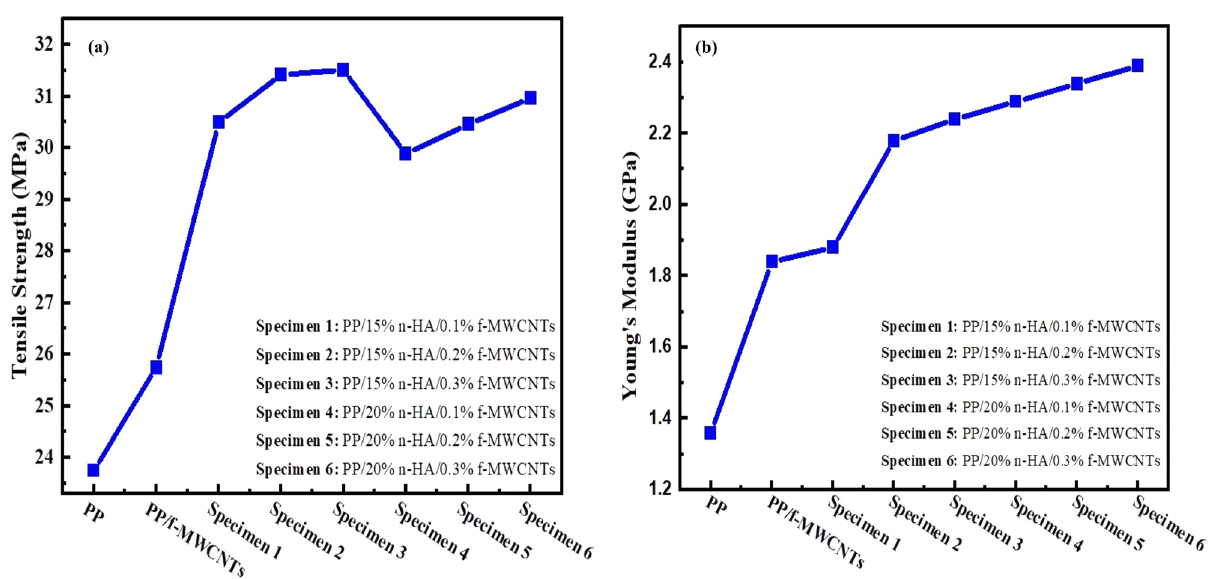
Figure 5. ( a ) Variations of tensile strength with n-HA for nanocomposites. ( b ) Variations of Young’s modulus with nHA for